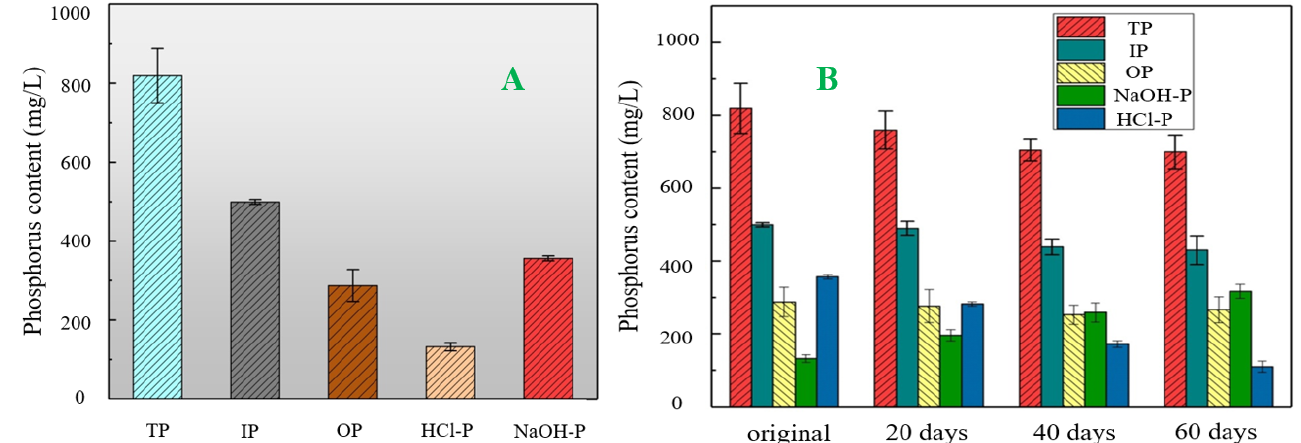
Figure 9. ( A ) The content of different phosphorus forms in the sediment; ( B ) the change of phospho- rus forms.